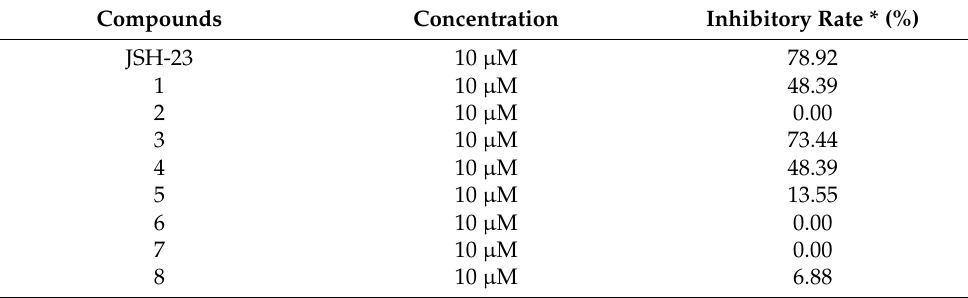
Table 2. NF- κ B-Dependent Reporter Gene Expression Assay results for compounds 1 – 8 .